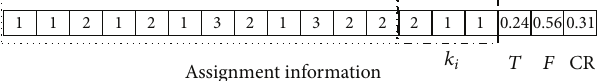
Figure 3: A decoded chromosome ( 𝑚 = 12 , 𝑛 = 3